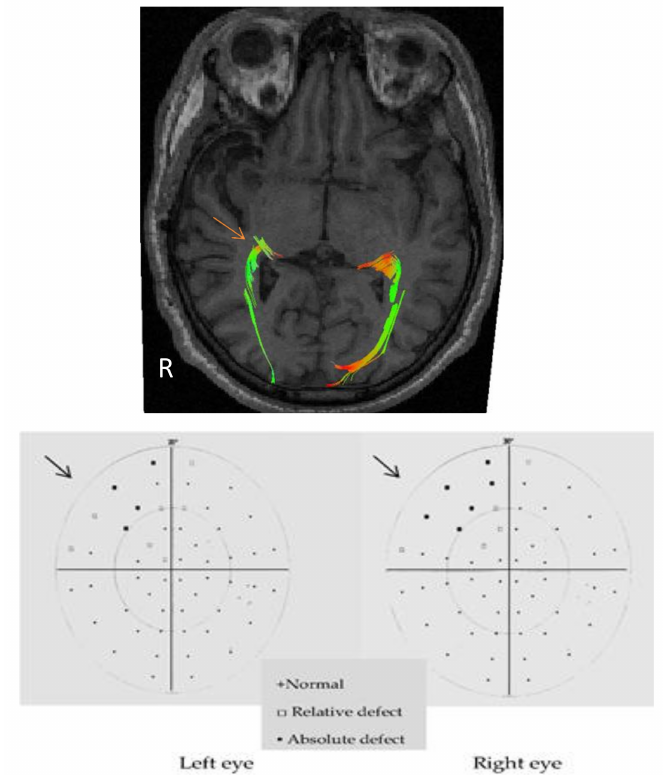
Figure 1. Tractography of optic radiations and perimetry of a patient with right lobectomy. Arrows indicate the pathological optic radiation (tractography) and the affected quadrants (perimetry). R: right side of the